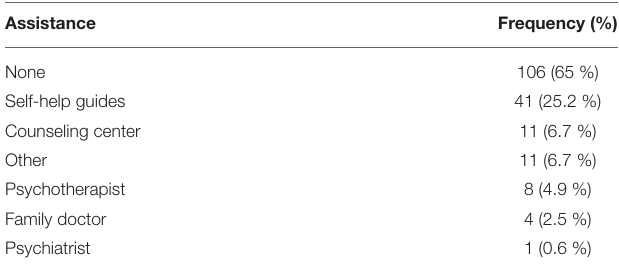
TABLE 1 | Frequencies and percentage of help service utilization with respect to test